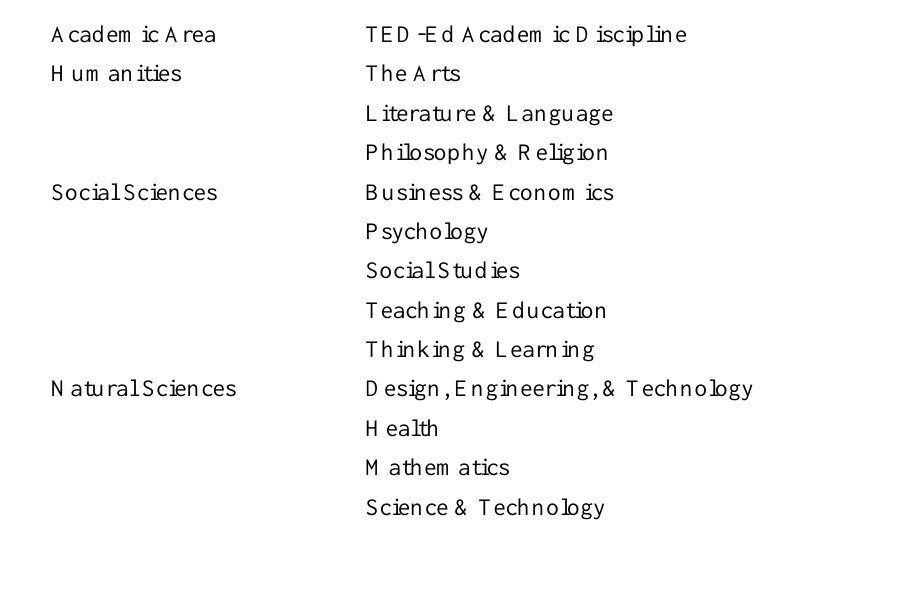
Three Academic Areas and Twelve Academic Disciplines